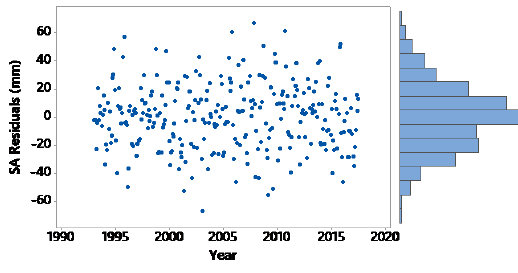
Fig. 9. SA residuals are in mm. RMS of the residuals is 23.1